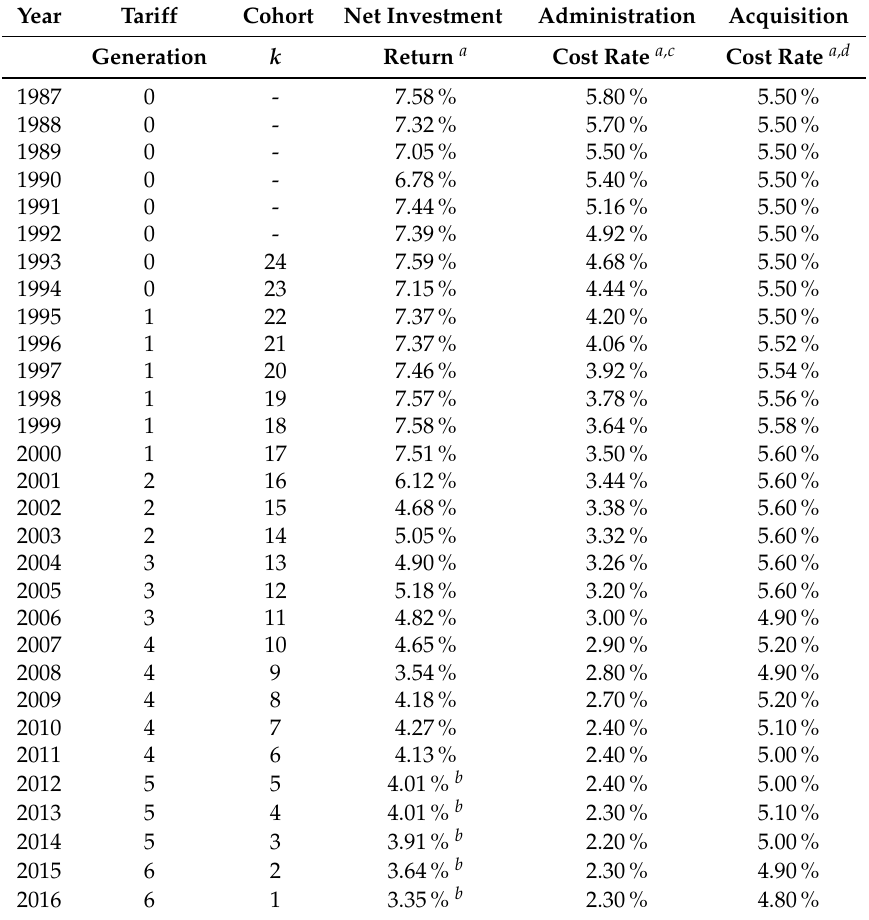
Table A1. Historic data from the German life insurance market used for deriving the portfolio of insurance